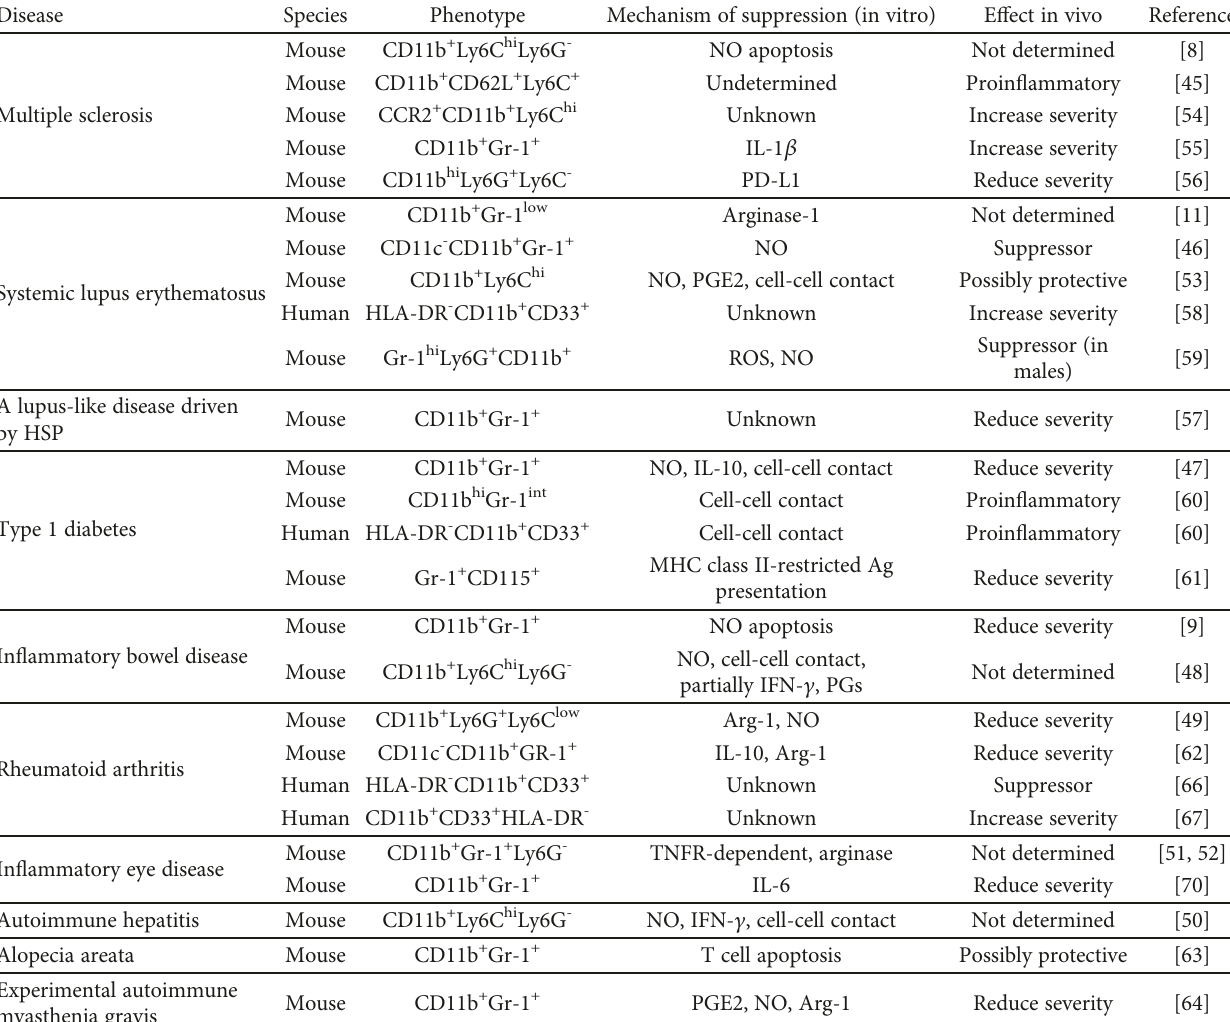
Table 1: Myeloid-derived suppressor cells in autoimmune